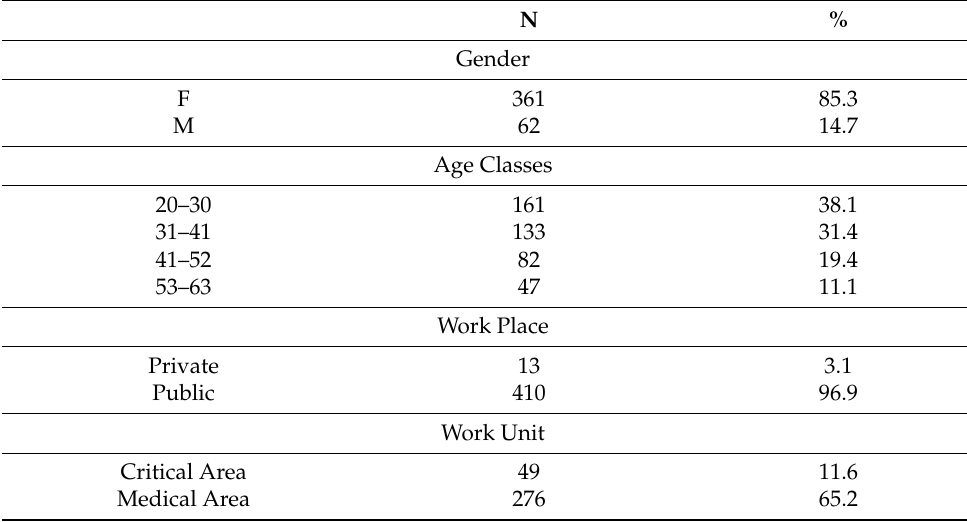
Table 1. Demographics statistic (N =